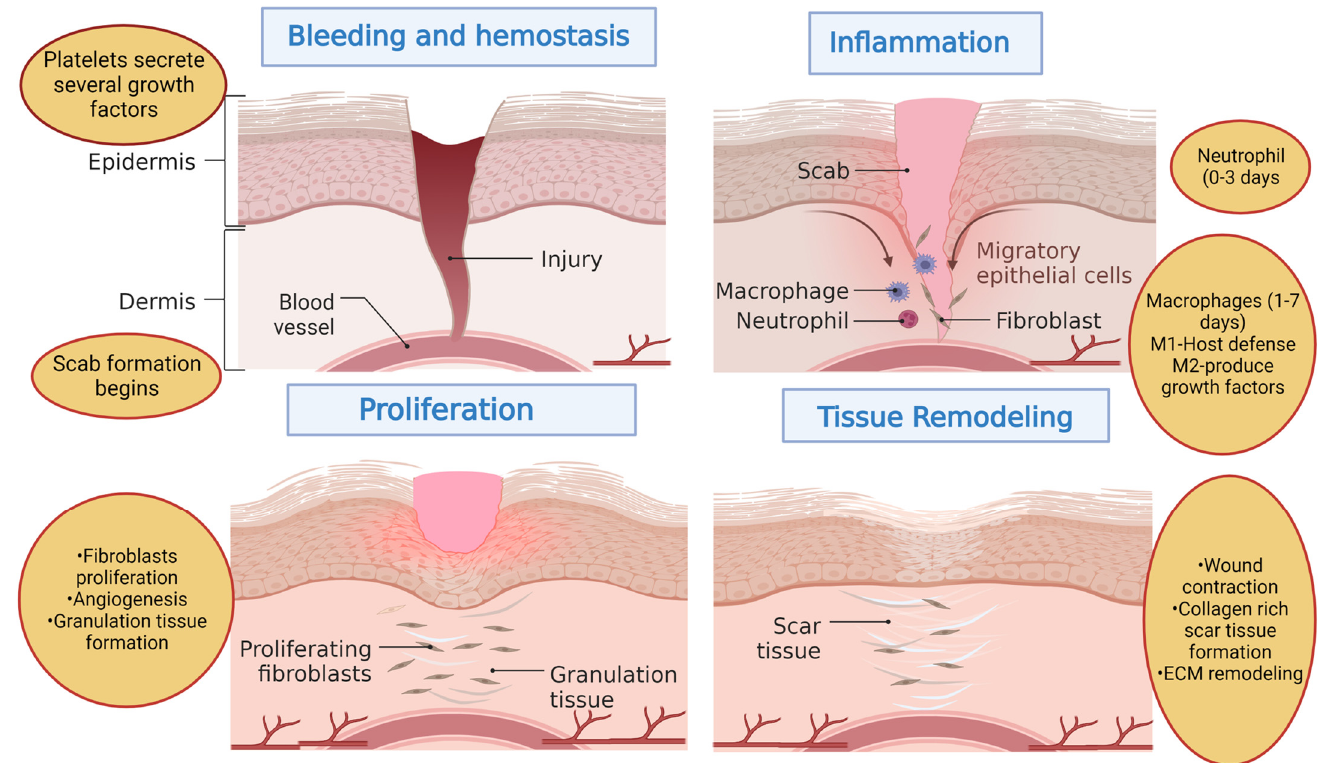
Figure 2. Different stages of wound healing. All the four phases with highlighted key events play a pivotal role in cutaneous wound healing.